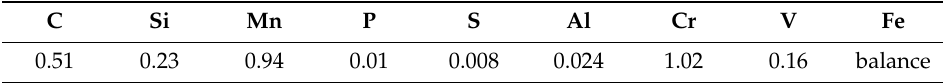
Table 2. Average composition of 51CrV4 spring steel (wt%).